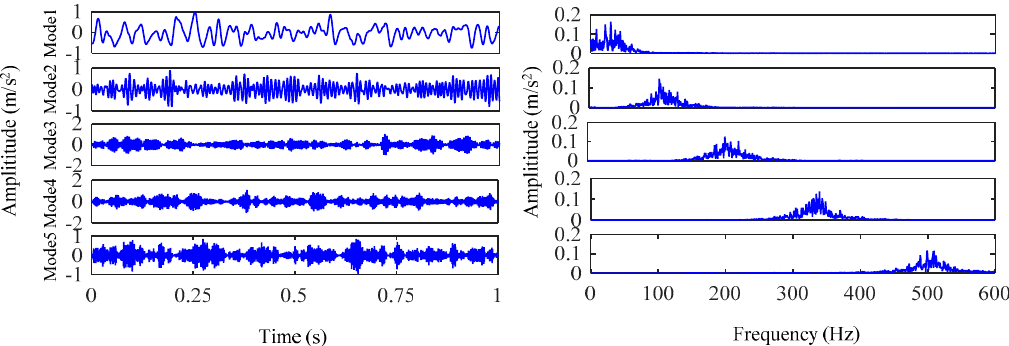
Figure 7. Decomposition results and corresponding frequency spectrum of modes with VMD.